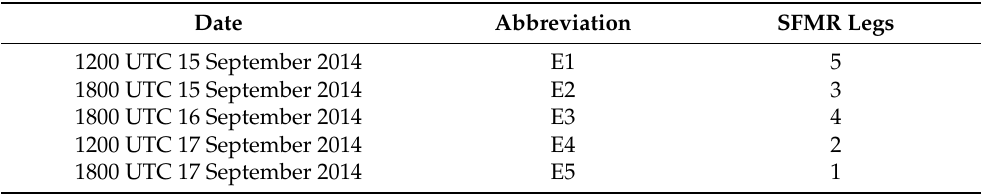
Figure 1. Edouard (2014) Best track maximum wind speed (Vmax; blue) with Tail Doppler Radar (TDR) data availability overlaid (green). Center of six-hourly DA windows marked with red dot. Table 2. Table of Edouard (2014). Time provided is the center of the 6 h data assimilation (DA) window in the six-hourly DA experiments, and the center of the corresponding batch of